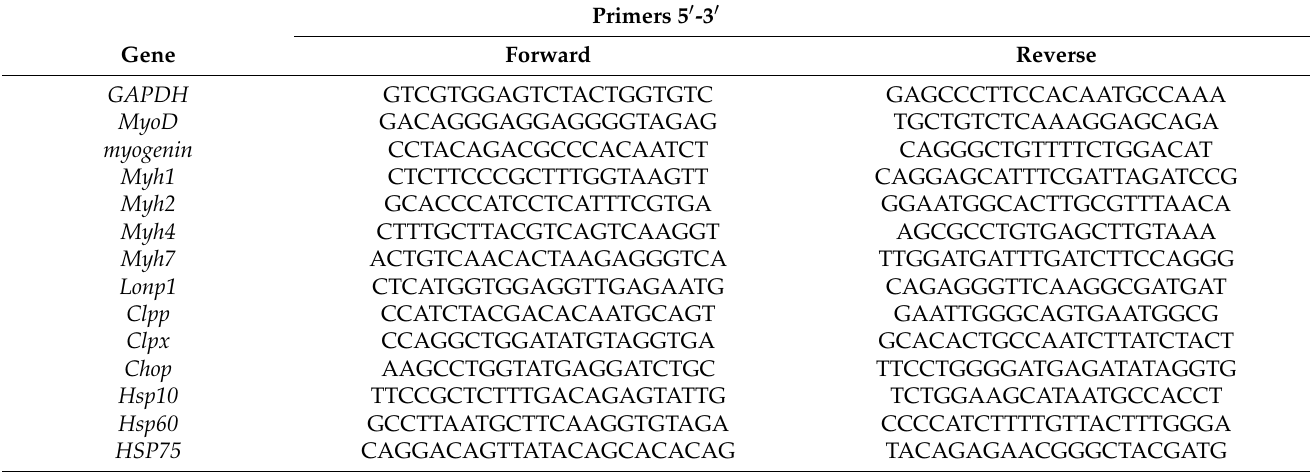
Table 2. Primer Sequences for mRNA expression